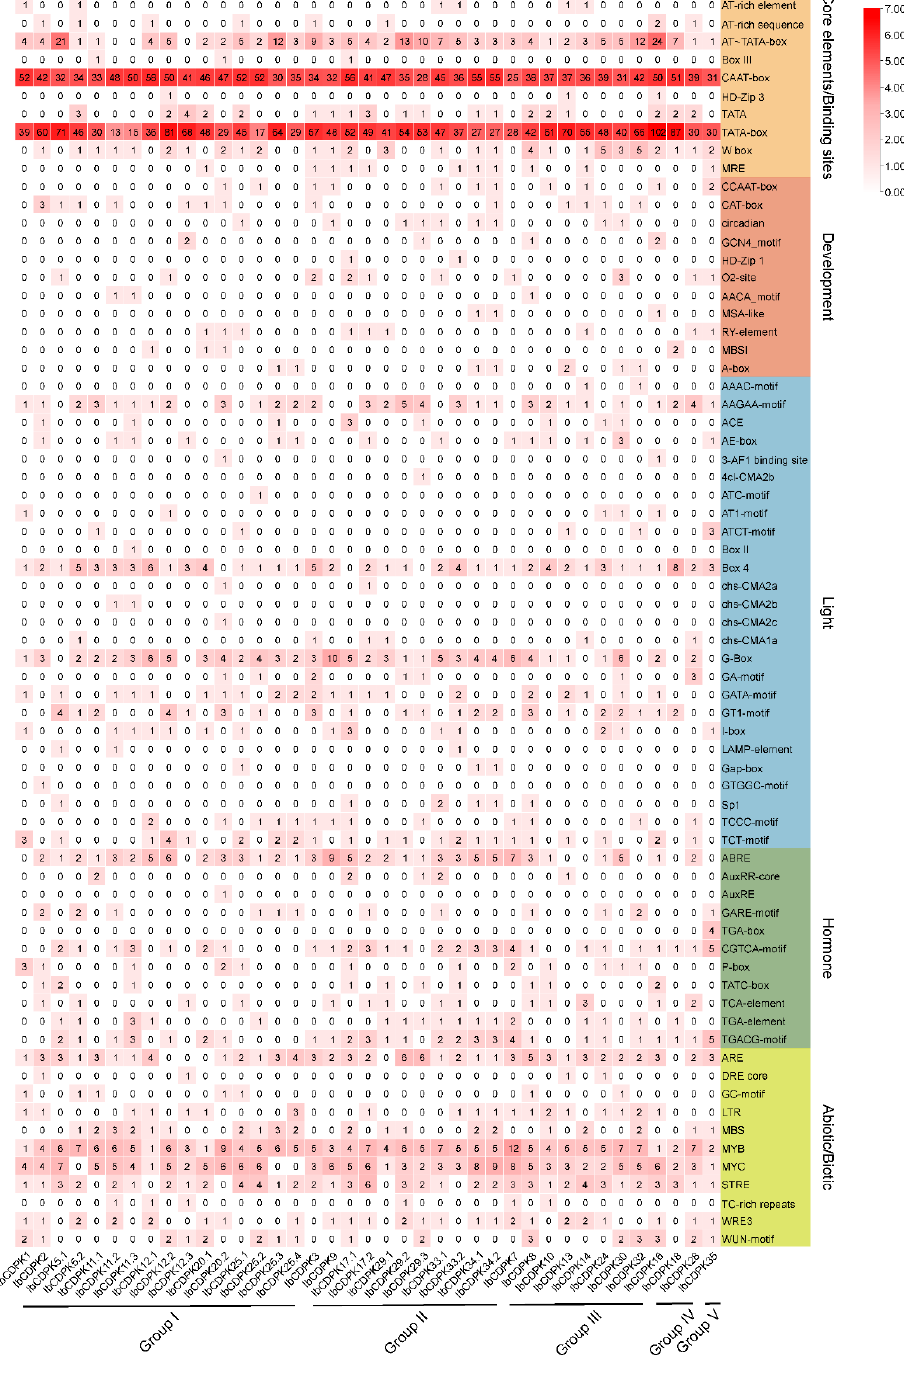
Figure 4. Cis -elements analysis of IbCDPKs . The cis -elements were divided into five groups. The degree of red colors represents the number of cis -elements upstream of the IbCDPKs .